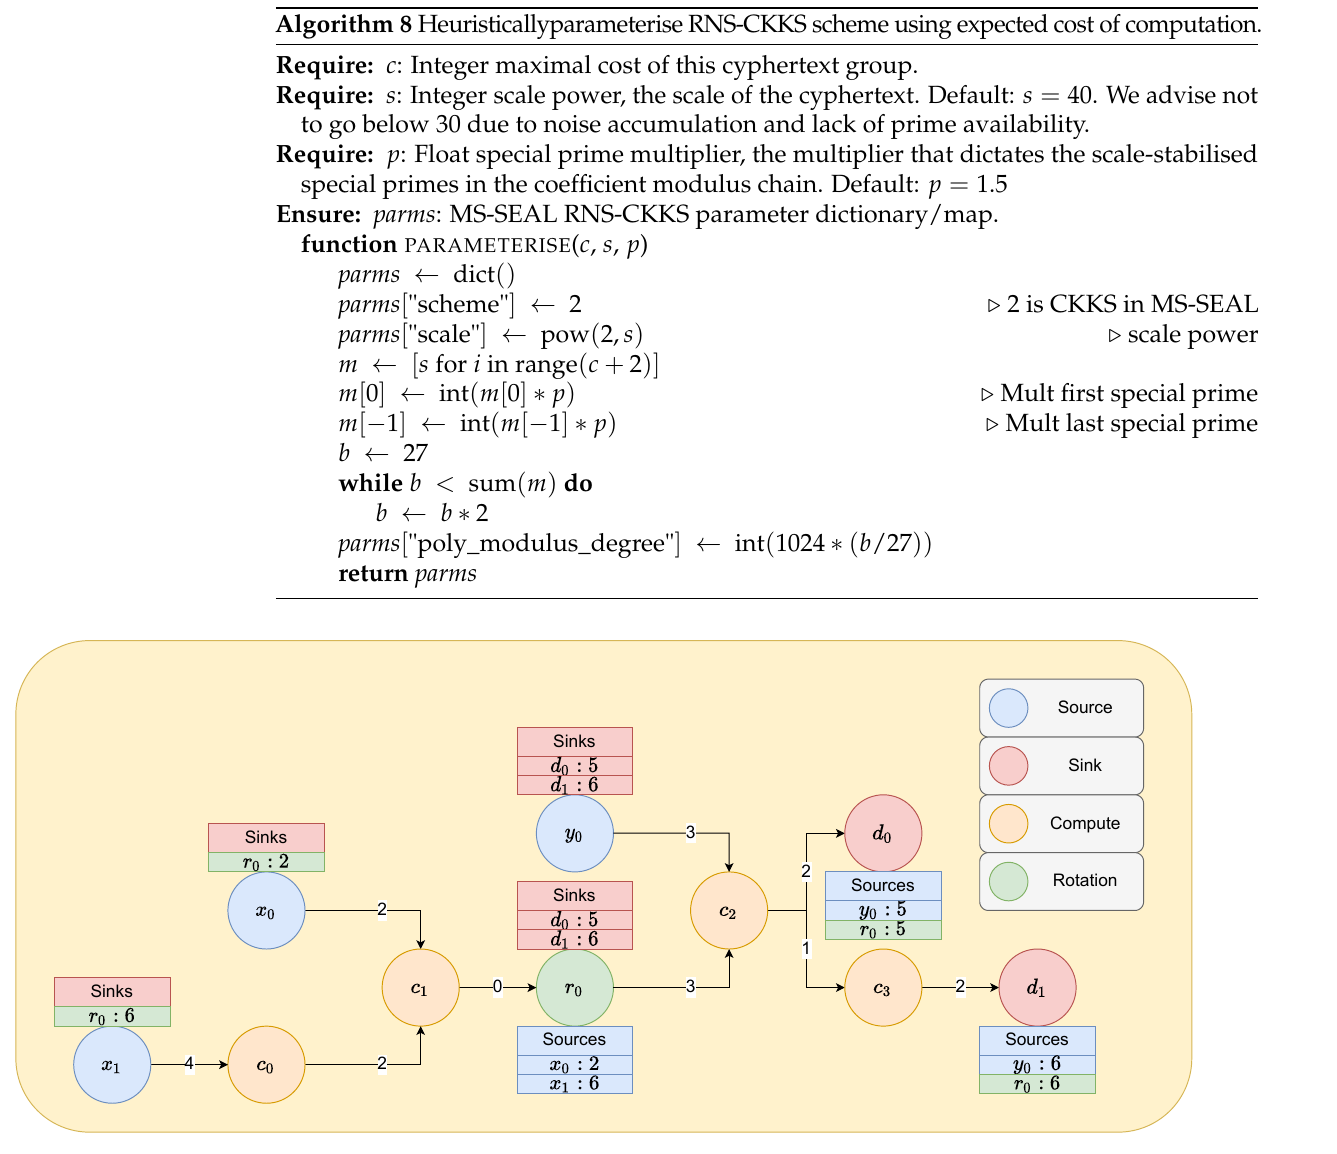
Figure 4. Example automatic FHE parameterisation problem over a multi-directed graph. Sources are where data become a cyphertext. Sinks are where cyphertexts become plaintexts. Computation nodes are generic nodes that represent some operation that can be applied to both cyphertexts and plaintexts. Explicit rotation nodes are where cyphertext keys are rotated, either to refresh them, or to change the form of the cyphertext, potentially into multiple smaller cyphertexts. Please note this does not necessarily follow the colour coding of our other automatically generated graphs